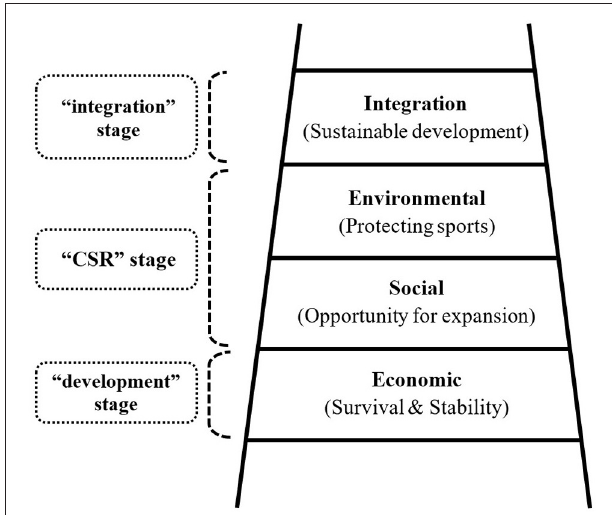
FIGURE 2 | The sustainability